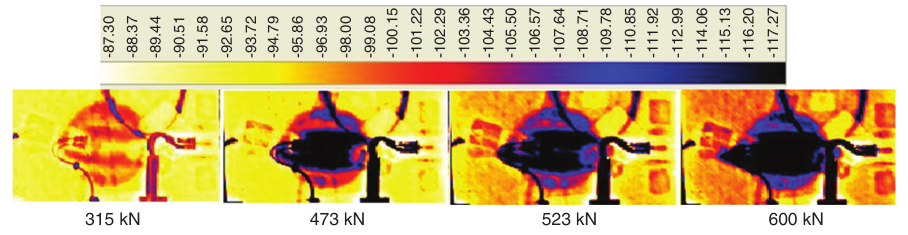
Figure 8 Phase images obtained at increasing compression loads. The buckling deformation and its propagation can be appreciated. The scale is referred to the phase angle expressed in